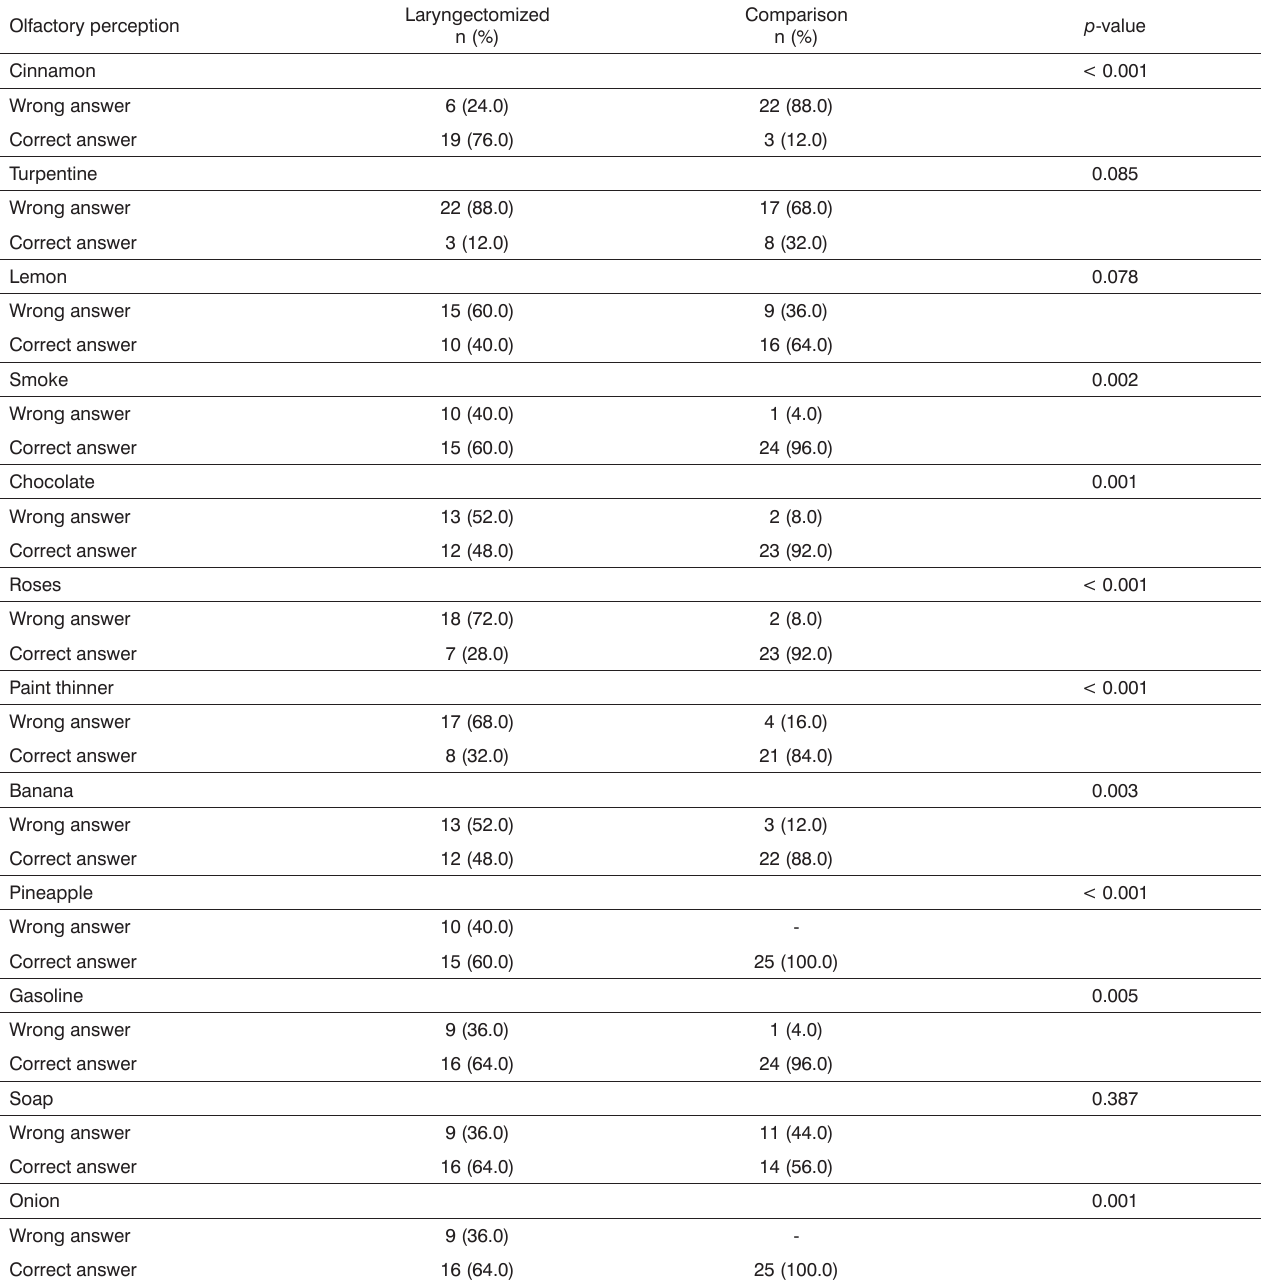
Laryngectomized n